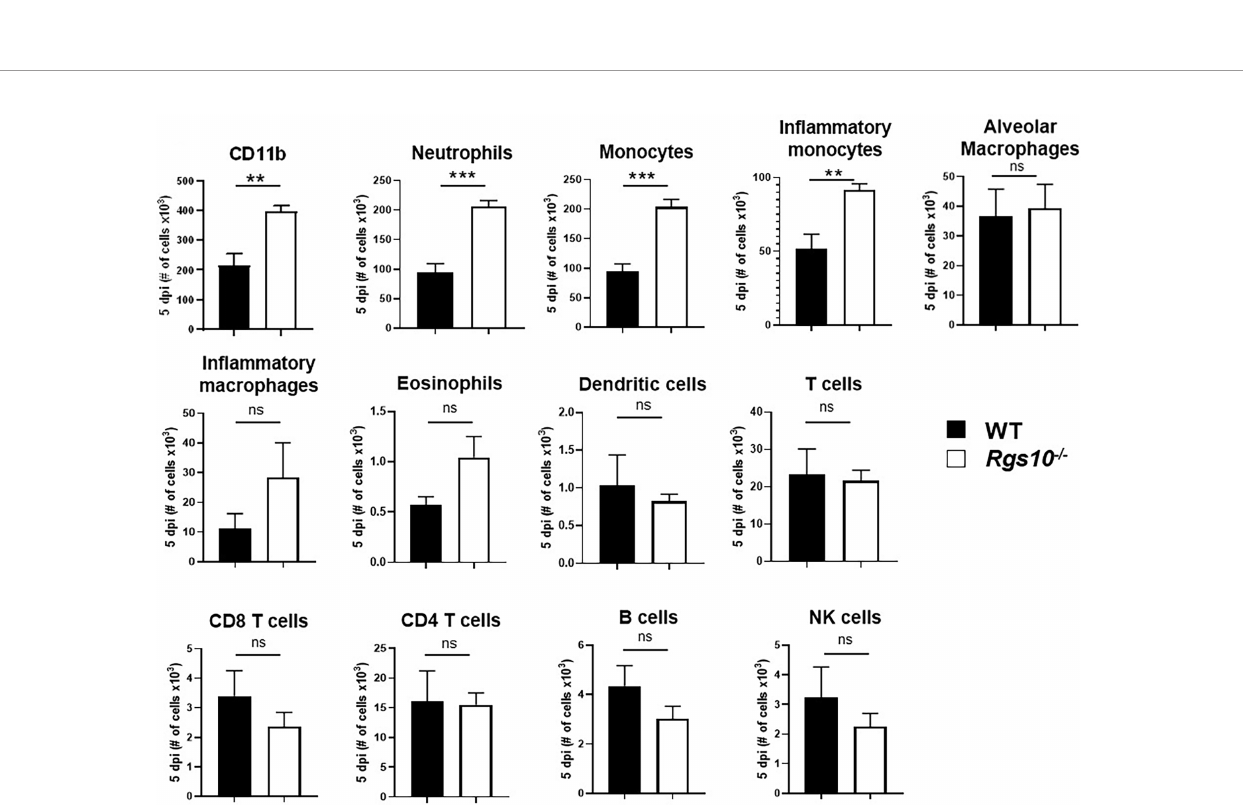
FIGURE 5 | Rgs10 de fi ciency increases neutrophil and monocyte recruitment into the airway during IAV infection. Phenotypic analysis of the indicated myeloid and lymphoid leukocyte subsets was measured by fl ow cytometry in PR8-infected lung BALF of WT and Rgs10-/- mice (n = 7) at 5 dpi. Data were analyzed for statistical differences using unpaired t-test between groups. Data are presented as mean ± SEM where **p < 0.01; ***p < 0.001, n.s. not signi fi